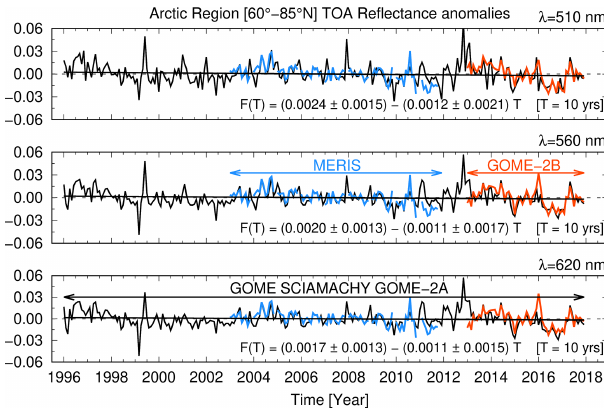
Figure 4. Time series of anomalies of R TOA at λ =510, 560, and 620nm derived from the values of Fig. 3. The values are computed with a seasonal cycle on a sensor basis (see Eq. D1). The linear trend F ( T ) is shown as a black line with the bootstrapped intervals at 95% confidence.